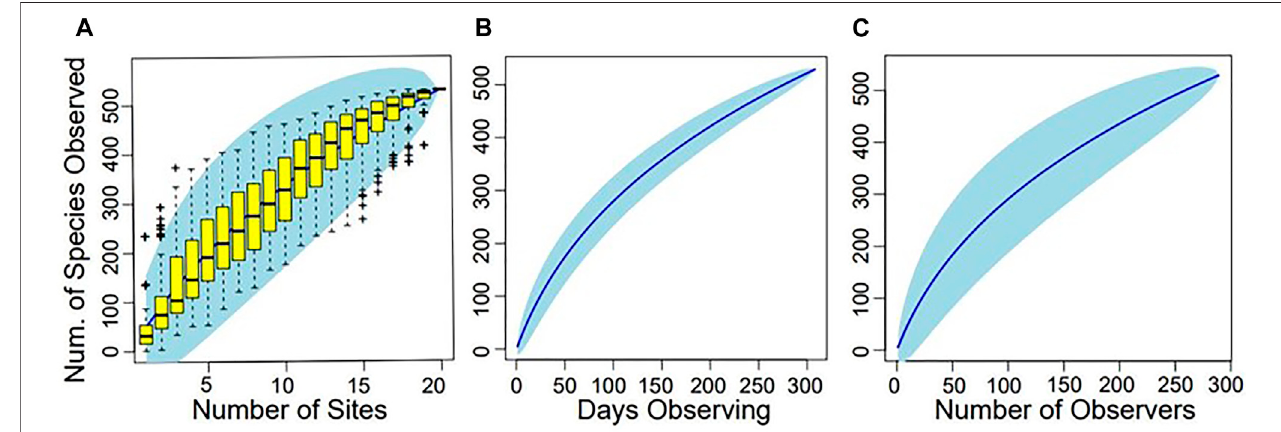
FIGURE 7 | Species accumulation curves over increasing numbers of (A) sites, (B) observation days, and (C) observers. None of the curves appear to have reached an asymptote, indicating sampling efforts were not duplications and further effort is needed to capture the full number of species present in the Humboldt County